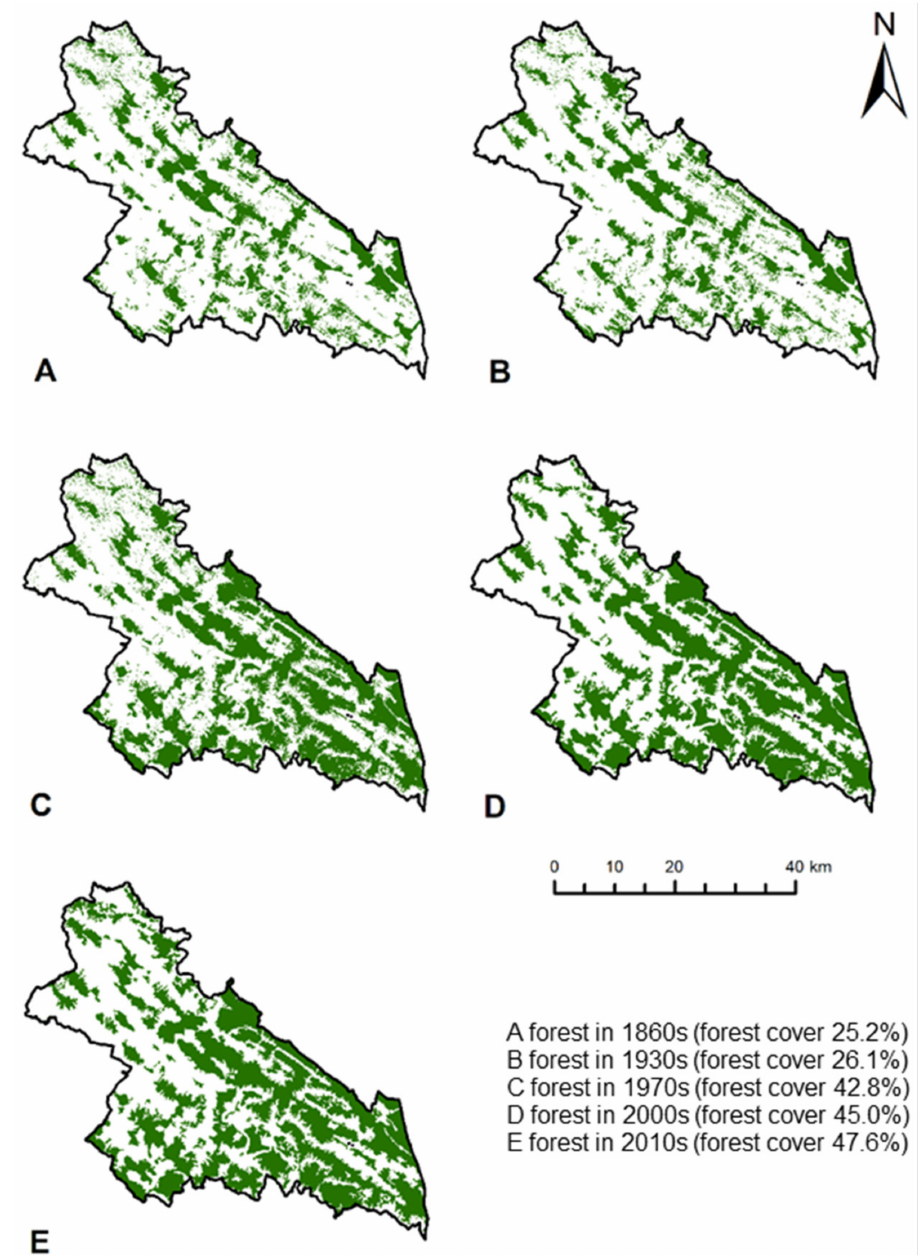
Figure 2. Changes in forest cover over